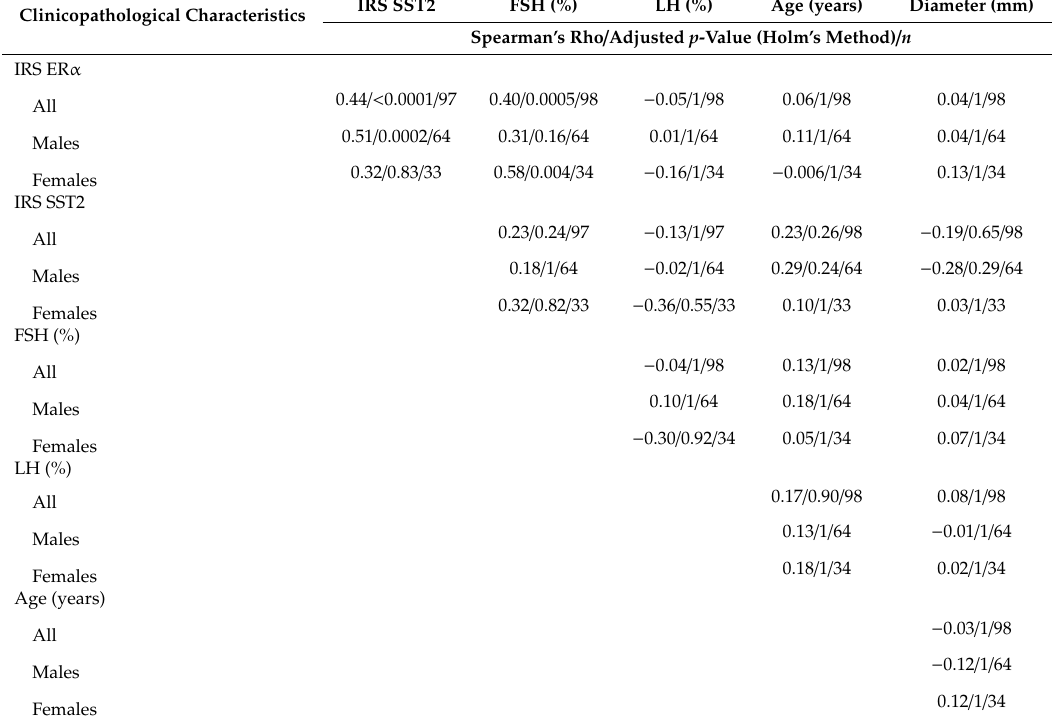
Table 2. Correlation matrix between IRS ER α , IRS SST2, FSH (%), LH (%), age and diameter in all, male and female